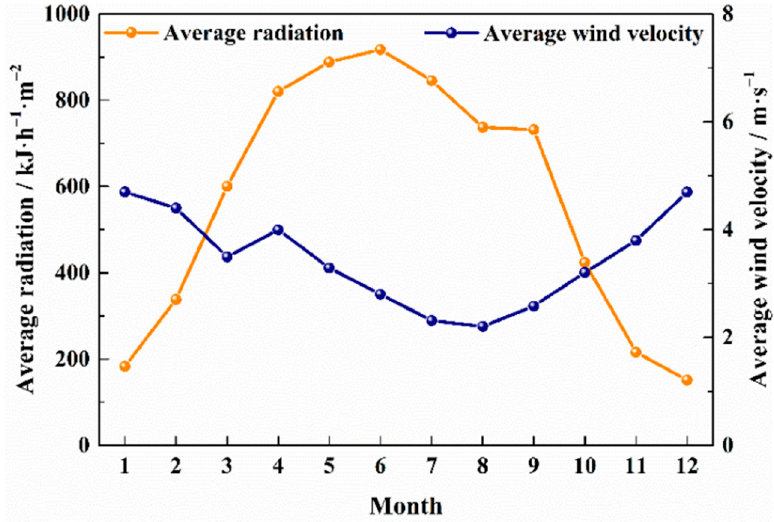
sources local data, the manufacturer data, and empirical formulae. The natural resources local data are implemented for 26 different regions in China. The installed capacity ratio between the PVs and the WTs is taken as the index of the distribution strategy to opti- mise the hybrid system. The optimal capacity ratio of the PVs and the WTs is found for each of the 26 regions. Figure 13 illustrates the complementarity between PV and WT re- sources. Figure 12. The flowchart of the software used to place EV charging stations powered by RESs [83]. A standalone hybrid WT/PV with a BESS system is modelled and simulated using TRNSYS software in [84]. PV source and WT powers are simulated using the natural re-